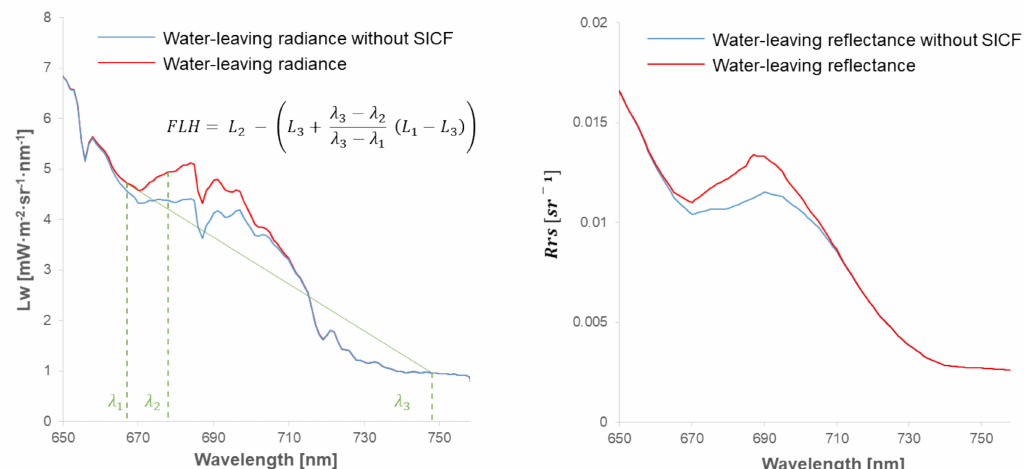
Figure 1. ( Left ): Illustration of the fluorescence line height (FLH) algorithm for an example showing the water-leaving radiance with and without sun induced chlorophyll fluorescence (SICF) contribution. The λ 1 , λ 2 , and λ 3 bands correspond to the band centers 667, 668, and 746 nm for MODIS and 665, 684, and 709 or 753 nm for OLCI. The difference between the apparent and true water-leaving radiance corresponds to the SICF signal. ( Right ): Equivalent remote sensing